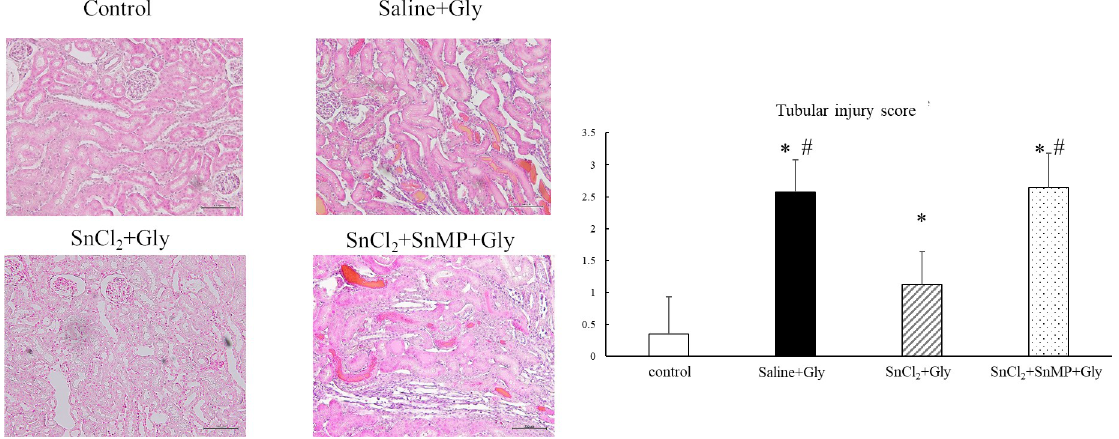
Fig 5. Effect of SnCl 2 pretreatment on renal histopathological changes at 24 h after Gly treatment. Renal tissues were stained with HE and assessed using a light microscope. Representative images 24 h after Gly treatment (HE staining, original magnification × 200, scale bar = 100 μ m). The severity of histopathological changes was evaluated using a tubular injury score. A total of 40 areas from a renal section of each group were assessed. The tubular injury was defined as tubular epithelial cell swelling, vacuolar degeneration, necrosis, and desquamation. Tubular injury score was graded by estimating the percentage of injured tubules as follows: 0, areas of injured tubules < 5%; 1, areas of injured tubules 5–25%; 2, areas of injured tubules 26–50%; 3, areas of injured tubules 51–75%; and 4, areas of injured tubules > 75%. The mean score for each kidney is provided, followed by the mean score for the group. Data are expressed as the mean ± SD (n = 4). � p < 0.05 vs control group; # p < 0.05 vs SnCl 2 +Gly